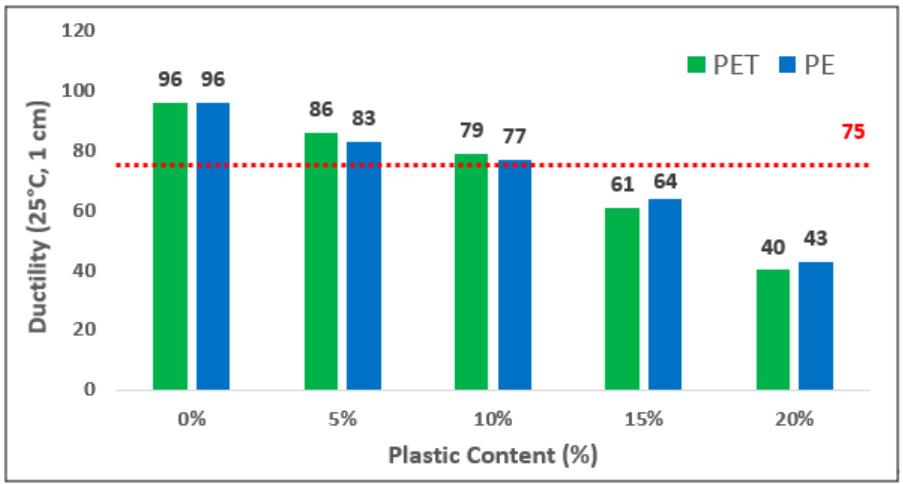
Figure 5. Ductility of Modified Bitumen versus different Plastic contents.